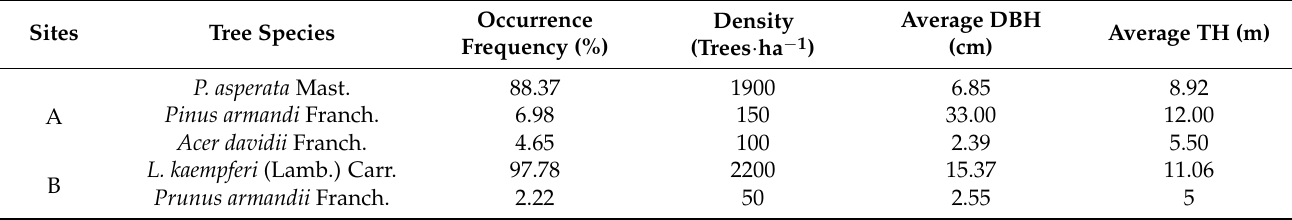
Table 2. Alpha diversity of the tree